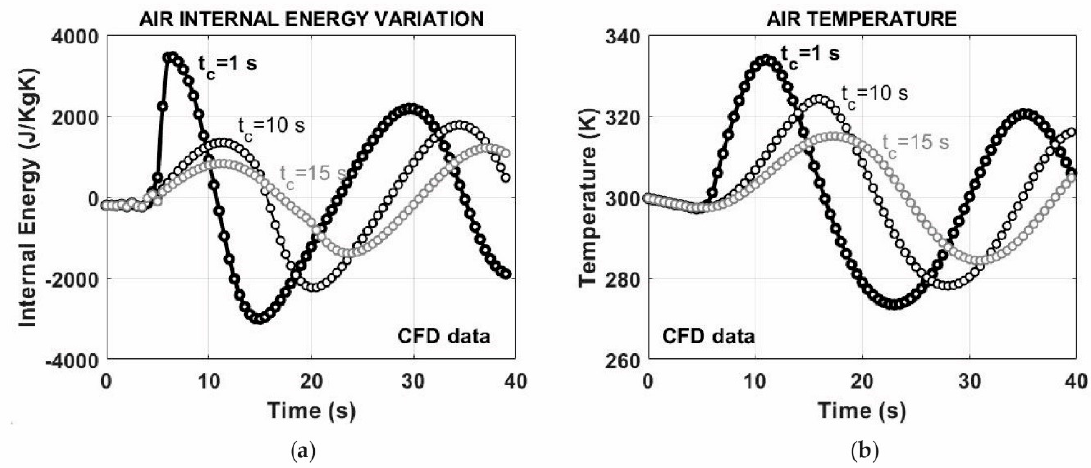
Figure 12. Thermodynamic analysis. ( a ) Internal energy variation for t c =1, t c =10, and t c =15 s of closure time of guide vanes; and, ( b ) Air temperature evolution for t c =1, t c =10, and t c =15 s of closure time of guide vanes.